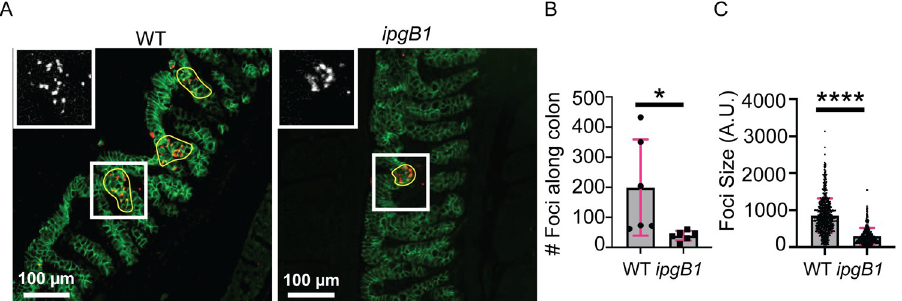
Fig 7. IpgB1 contributes to S . flexneri invasion and cell-to-cell spread in vivo . (A) Representative images of colon sections infected with wild type or ipgB1 S . flexneri at 8 hr postinfection. Yellow lines delineate individual infection focus and demonstrate how foci size is quantified. Insets in the top left show a zoom-in of the area outlined by the white box and displays single channel image corresponding to S . flexneri in an infection focus. E-cadherin, green; S . flexneri , red. Scale bar, 100 μ m (B) Graph depicting total number of foci measured along entire colon at 4 hr postinfection. Each dot represents one animal and grey bars show average of six biological replicates. Error bars indicate standard deviation. Unpaired two-tailed t-test; � , p < 0.05 (C) Graph depicting foci size in infected colons at 8 hr postinfection. Each dot represents one focus and grey bars show average foci size across six biological replicates. Error bars indicate standard deviation. Unpaired two-tailed t-test; ���� , p < 0.0001.